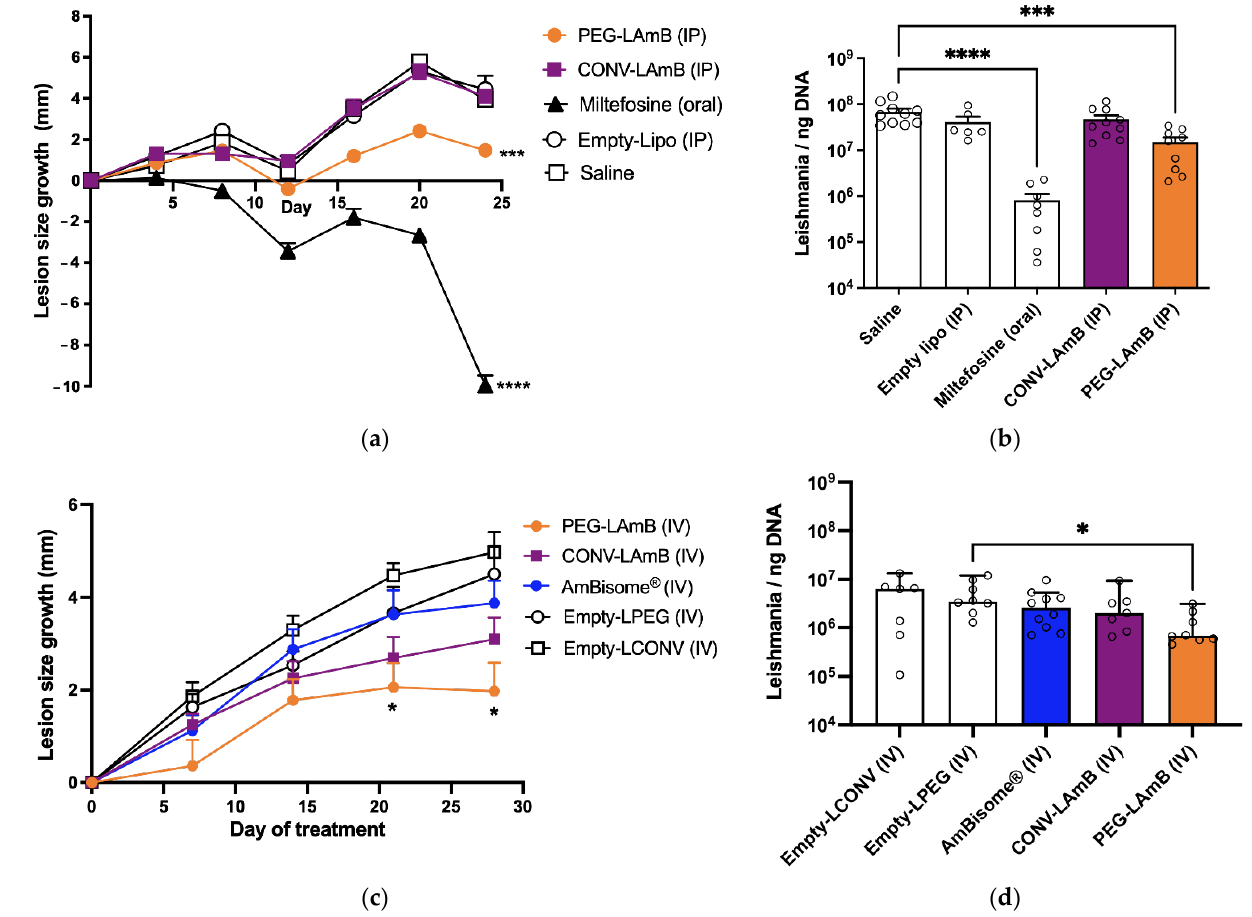
Figure 5. Antileishmanial efficacies of conventional and PEGylated liposomal AmB by IP ( a , b ) or IV ( c , d ) routes in murine model of cutaneous leishmaniasis. BALB/c mice were infected intradermally with Leishmania amazonensis . Treatments were initiated 75 days after infection with 7 doses of the following formulations. ( a , b ) CONV-LAmB group received the conventional liposomal AmB formulation at 5 mg/kg, every 4 days by IP route; PEG-LAmB group received the PEGylated liposomal AmB formulation at 5 mg/kg, every 4 days by IP route; Miltefosine group received miltefosine by oral route at 10 mg/kg daily for 24 days; Empty-Lipo group received by IP route a mixture of empty conventional and PEGylated liposomes at 1:1 lipid mass ratio and the same regimen as in CONV-LAmB group; Saline group received isotonic saline by IP route. ( c , d ) CONV-LAmB group received the conventional liposomal AmB formulation at 5 mg/kg, every 4 days by IV route; PEG-LAmB group received the PEGylated liposomal AmB formulation at 5 mg/kg, every 4 days by IV route; AmBisome ® group received AmBisome ® at 5 mg/kg, every 4 days by IV route; Empty-LCONV group received by IV route empty conventional liposomal formulation at the same regimen (lipid dose, intervals) as that in CONV-LAmB group; Empty-LPEG group received by IV route empty PEGylated liposomal formulation at the same regimen (lipid dose, time intervals) as in PEG-LAmB group. Treatment efficacy was evaluated through measurement of lesion size growth ( a , c ), analyzed by two-way ANOVA for repeated measures) and determination of parasite load by qPCR ( b ) and ( d ). ( b ) Data shown as means + SEM and analyzed through one-way ANOVA followed by Dunnett’s multiple comparison post-test. ( d ) Data shown as medians + 95% confidence interval and analyzed by Kruskal-Wallis followed by Dunn’s multiple comparison post-test. * p < 0.05, *** p < 0.001 and **** p <